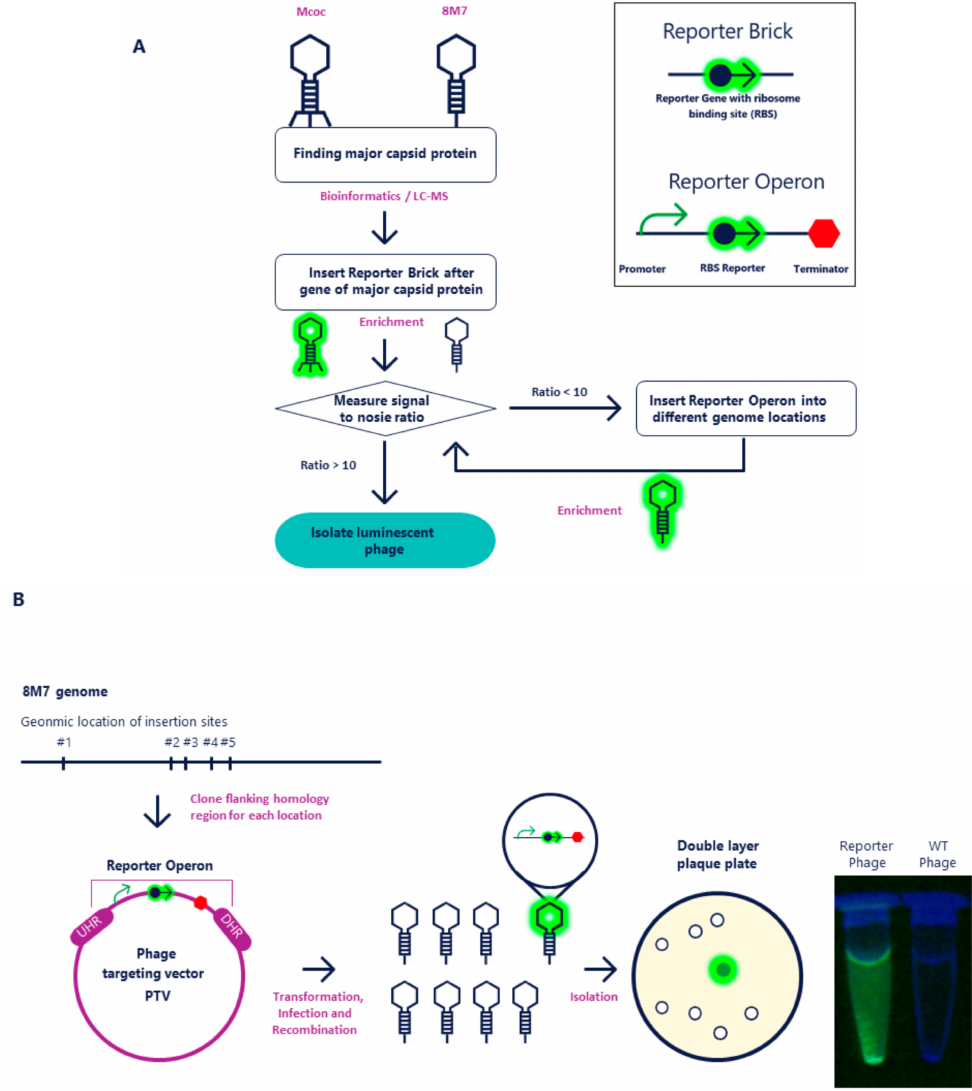
Figure 2. The Reporter Brick and Reporter Operon phage engineering design and workflow. ( A ) The overall workflow of the engineering method. Mcoc phage represents the standard approach in which adding the Reporter Brick after the major capsid protein is sufficient to attain a luminescent phage of high sensitivity. Phage 8M7 represents the alternative strategy employed when the standard approach does not produce a highly sensitive luminescent phage. In this strategy, a Reporter Operon consisting of a promoter, RBS–reporter gene and terminator is inserted in several different phage genome locations and the optimal location is determined by the signal-to-noise ratio. ( B ) Strategy of Reporter Operon cloning leading to the isolation of 8M7 luminescent reporter phages. Different phage genome locations were selected for the insertion of the Reporter Operon by homologous-recombination-based cloning with phage targeting vectors (PTVs). Transformed KP2H7 bacteria carrying the PTVs are infected with 8M7 wildtype (WT) phages. Recombinant phages which carry the luminescent reporter operon emit a detectable signal upon phage interaction with the target